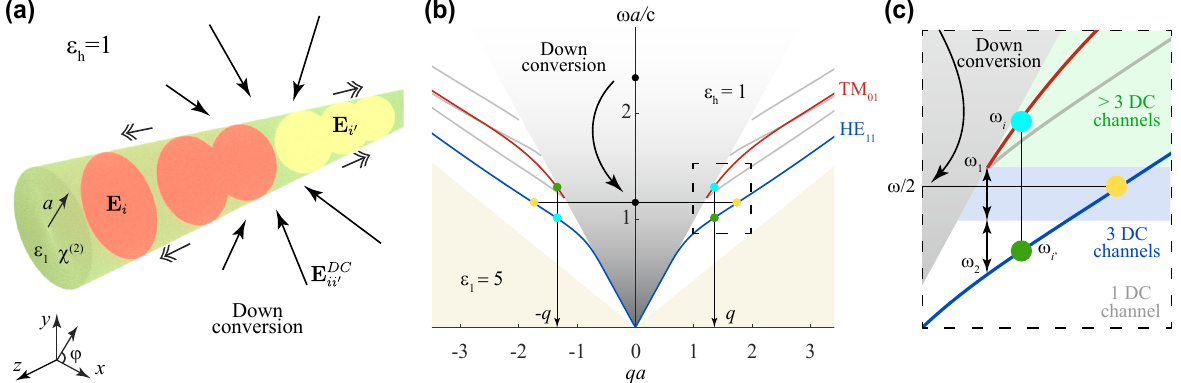
Figure 1: Generation of waveguided entangled photon pairs by down-conversion in an optical waveguide. (a) Illustration of a cylindrical waveguide (radius a , material permittivity 𝜖 incident photon can be down-converted via the second-order nonlinear response of the waveguide material (susceptibility 𝜒 (2) ) to produce two waveguided photons within modes i and i ′ characterized by electric fields E + q = 0. (b) Dispersion diagram of waveguide modes (normalized frequency 𝜔 a ∕ c as a function of normalized wave vector qa ) satisfying q i i ′ = 5 and 𝜖 = 1. The light cones in the waveguide and host materials (white and gray areas, respectively) limit the existence of guided for 𝜖 1 h modes. We highlight the two lowest-order modes that possess nonzero longitudinal field components (HE down-conversion with a small number of photon-pair emission channels: one symmetric (yellow circles) and two asymmetric (blue and green circles) channels. (c) Detail of photon-pair emission channels, showing the threshold frequency of the TM mode with the same wave vector, and the number of down-conversion channels available depending on the incident photon frequency HE 11 𝜔 (1, 3, and > 3 in white, blue, and green areas). Each channel has ± q and ± m